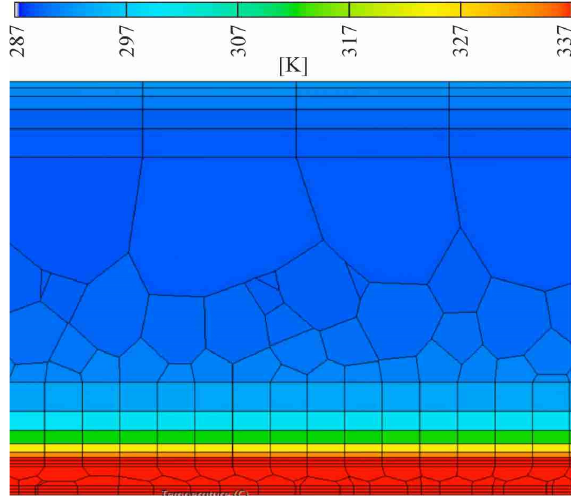
Figure 8. Cross ‐ sectional temperature distribution in the test section. Figure 8. Cross-sectional temperature distribution in the test